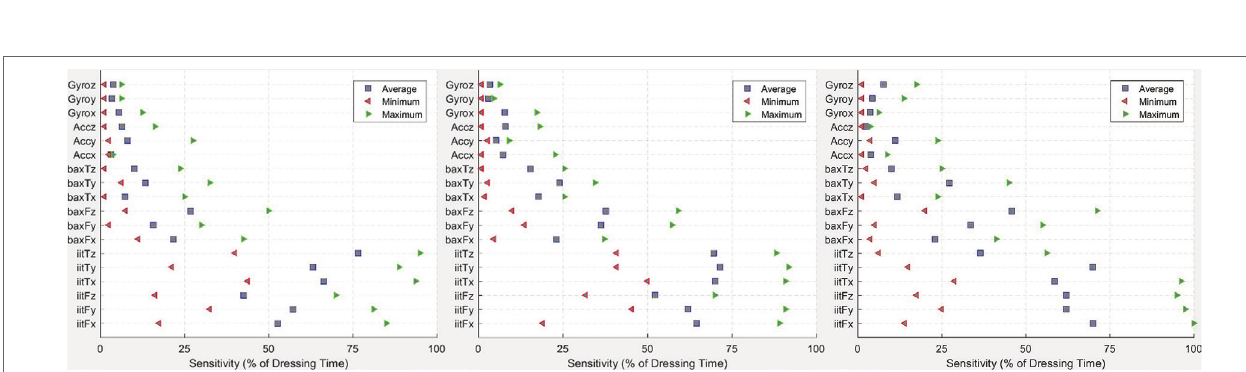
FigUre 8 | example of cross-comparison matrix for the iiT load cell torque ( y -axis) for poses 1–3 (left to right) showing the percentage of dressing time without overlap of confidence intervals ( R s ) .